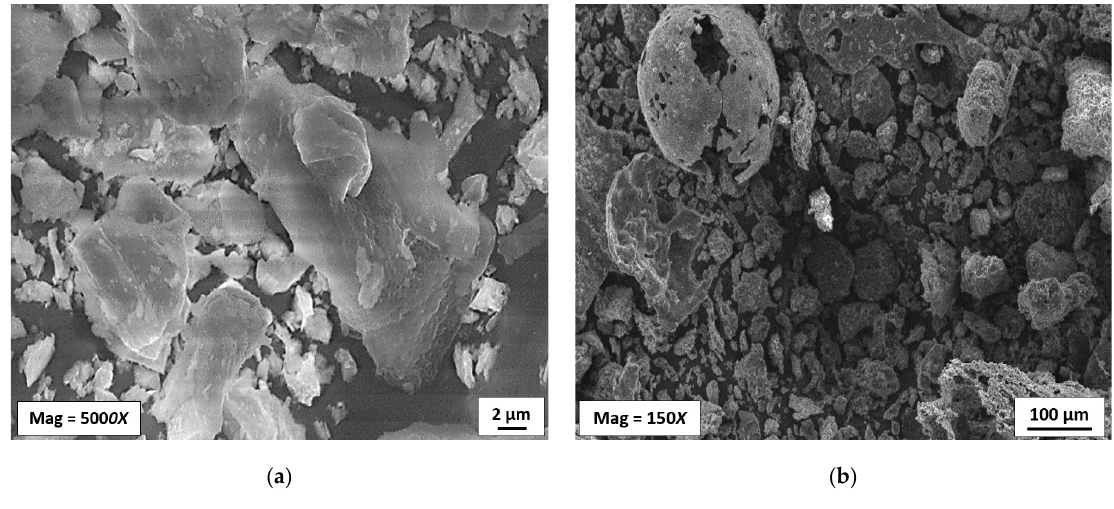
Figure 4. SEM images: ( a ) cement; ( b ) coal ash. Table 3. Chemical constituents of used cement and coal ash.